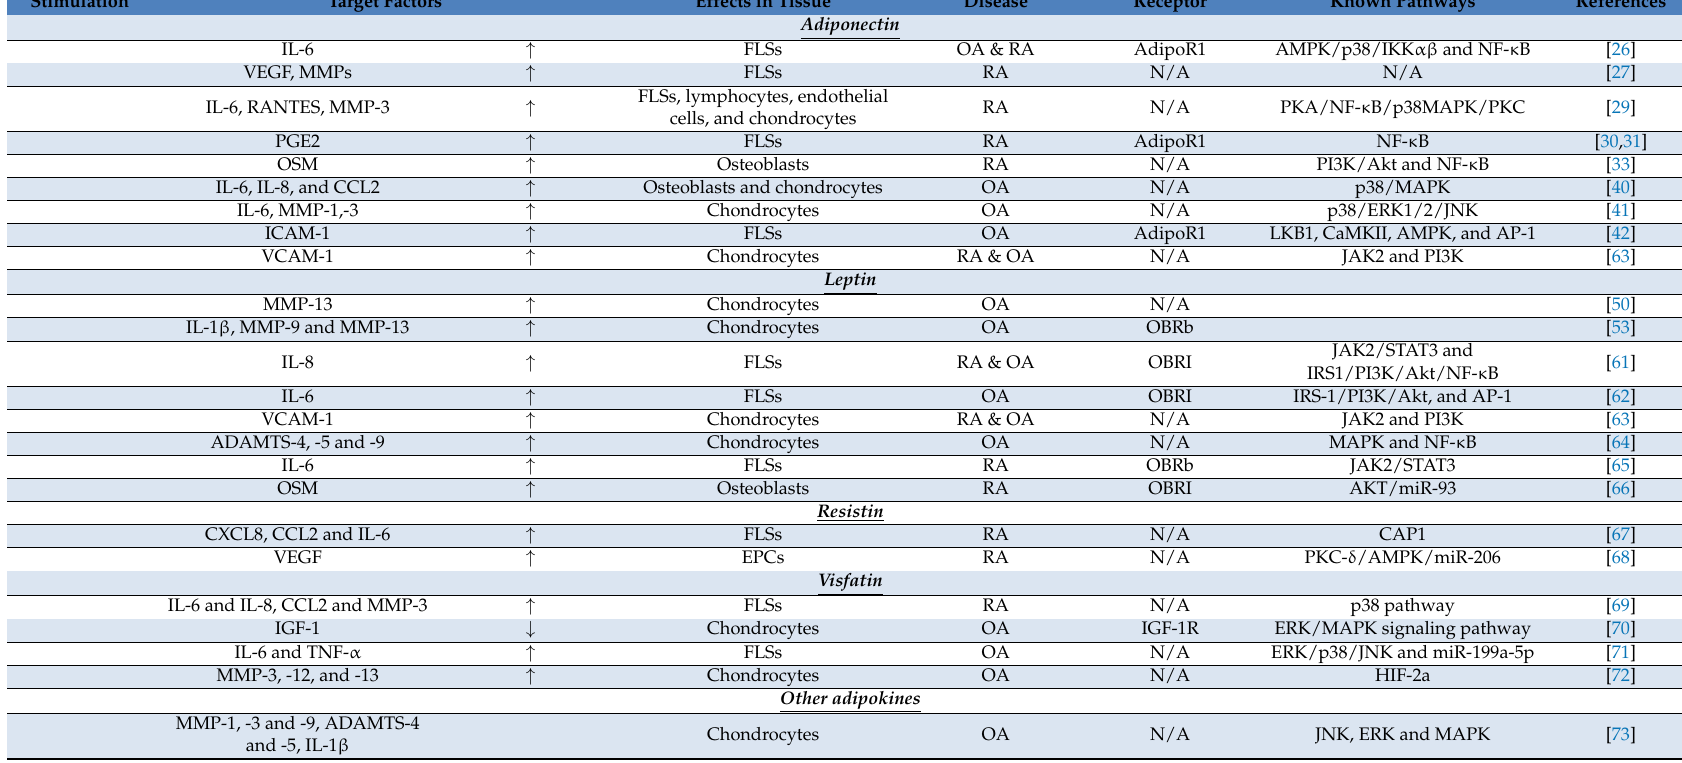
Table 1. Adipokines implicated in rheumatoid arthritis and